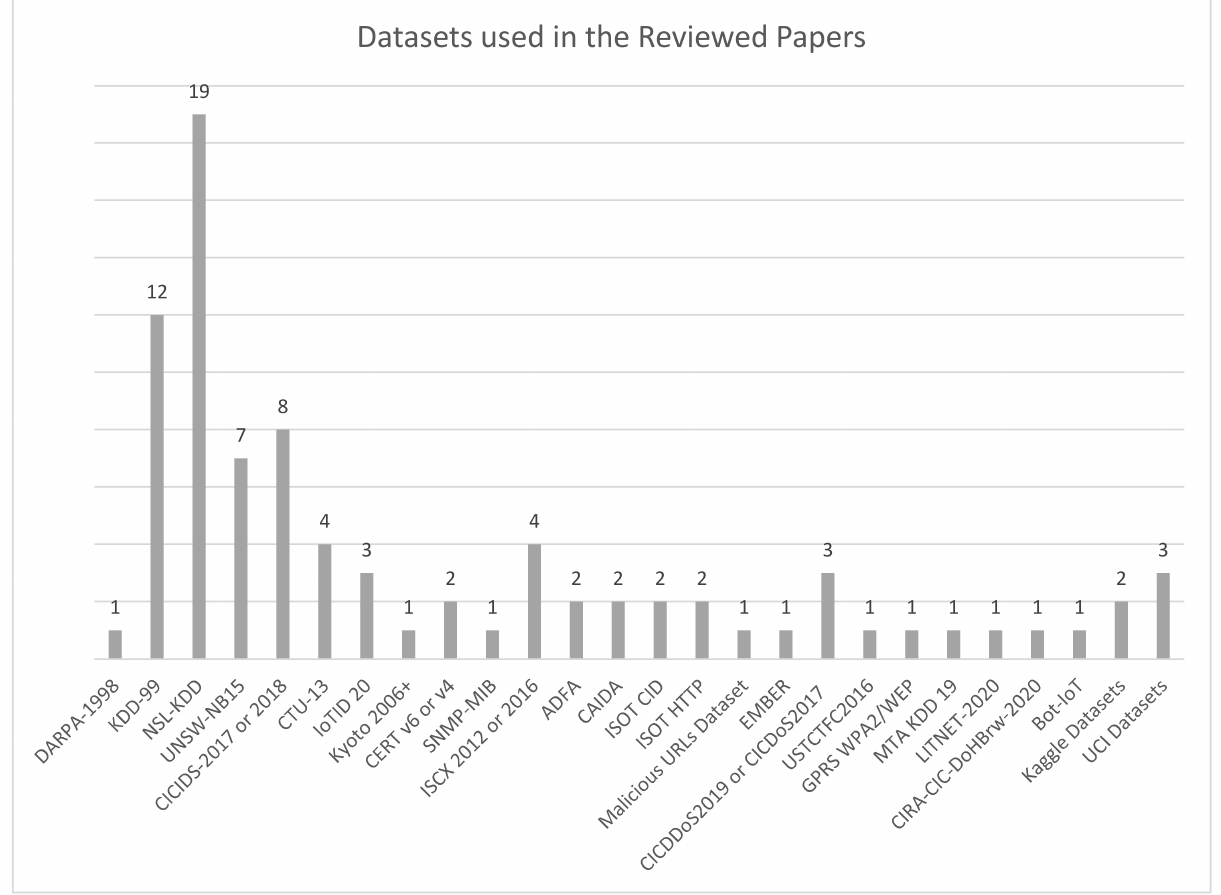
Figure 2. Datasets used in the reviewed